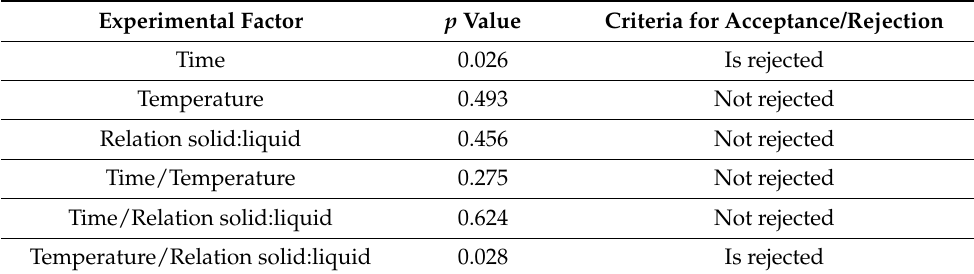
Table 2. Hypothesis testing to determine the optimal parameters. Experimental Factor p